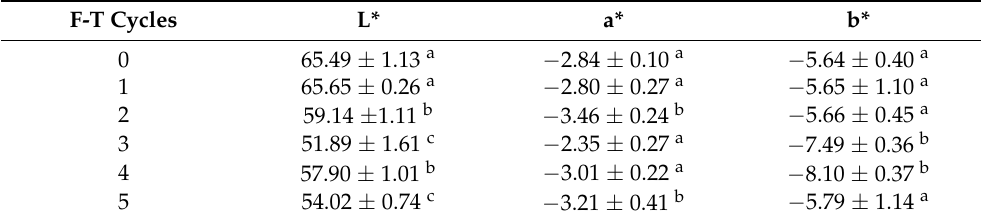
Table 1. Color change of cuttlefish flesh that had undergone repeated freeze–thaw cycles.